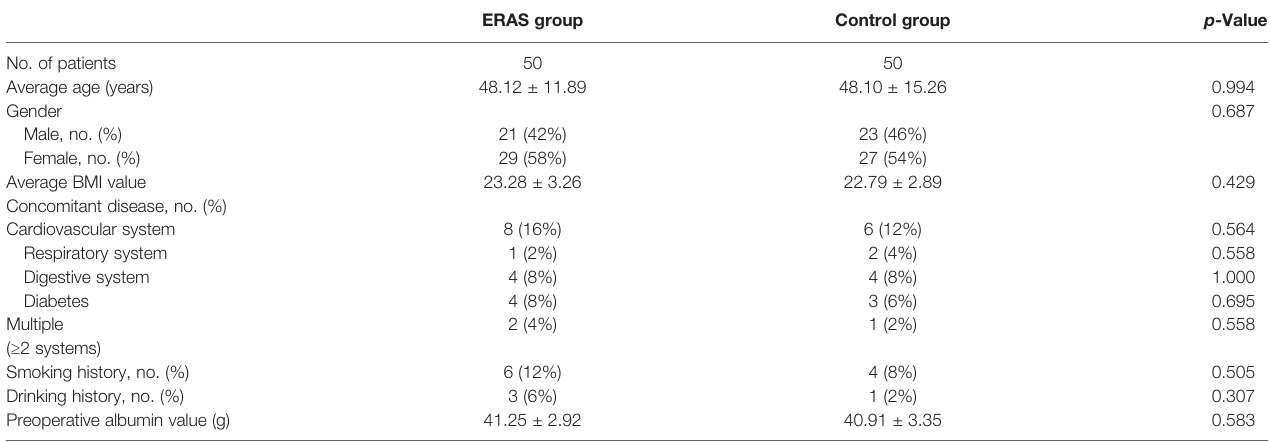
TABLE 1 | Clinical characteristics of 100 patients who underwent